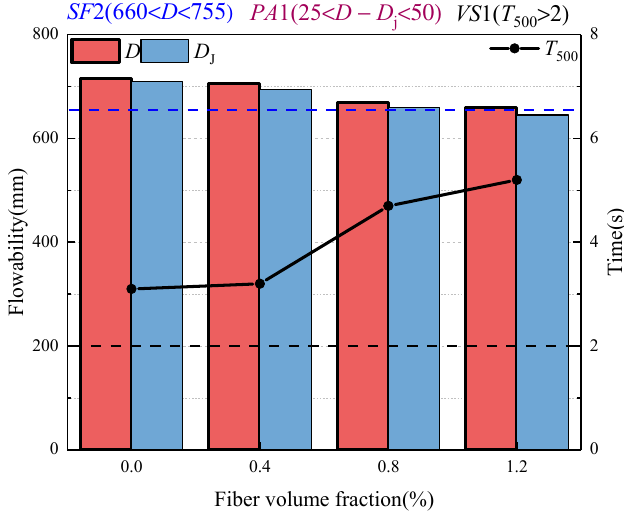
Figure 6. Workability of fresh self-compacting SFRC.